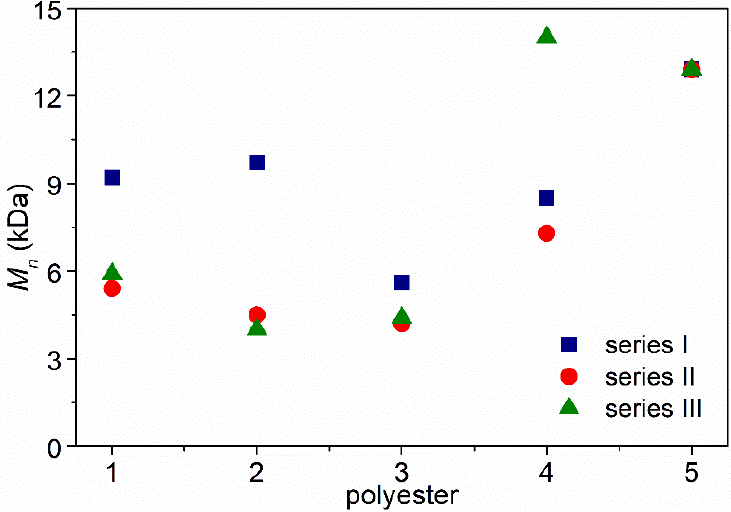
Figure 4. Average number molar mass ( M n ) in Series I–III.